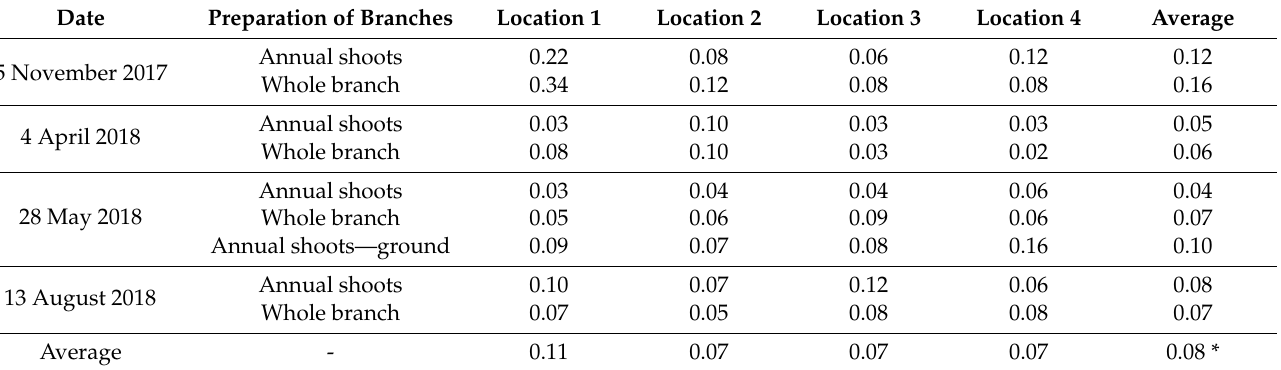
Table 1. Yield of essential oil (%) obtained from 50 g of each